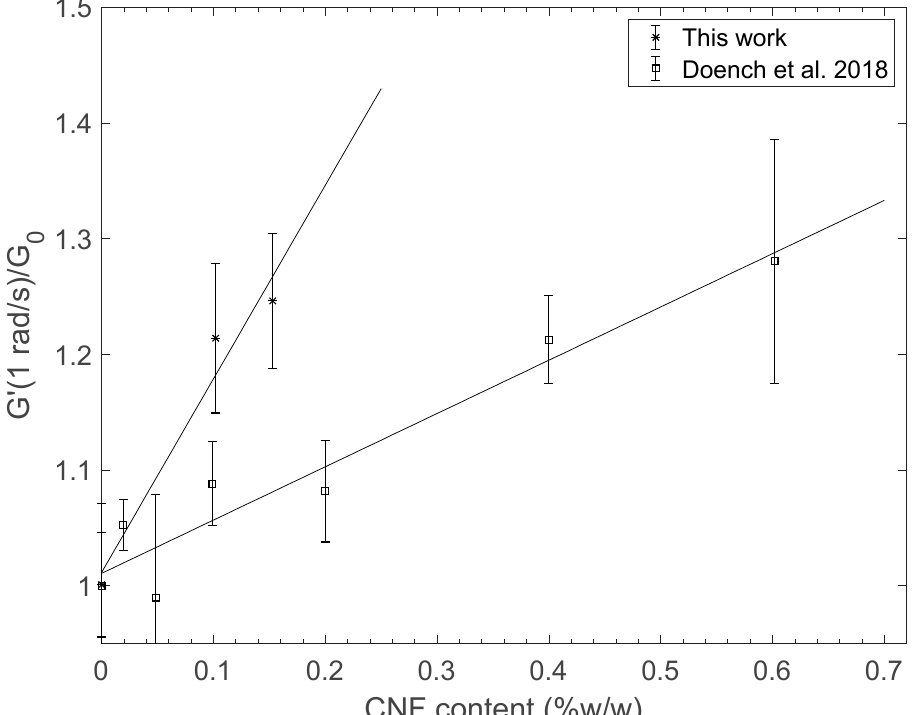
Figure 6. (*): Evolution of the elastic part of the shear modulus of hydrogels obtained from the controlled polyelectrolyte assembly of CHI and highly charged CNF by desalting, in normalized scales. The value of G 0 for non-reinforced systems obtained in this work was close to 0.31 kPa. These results are compared with literature data ( □ ) for CHI/CNF hydrogels obtained with weakly charged CNF [32].